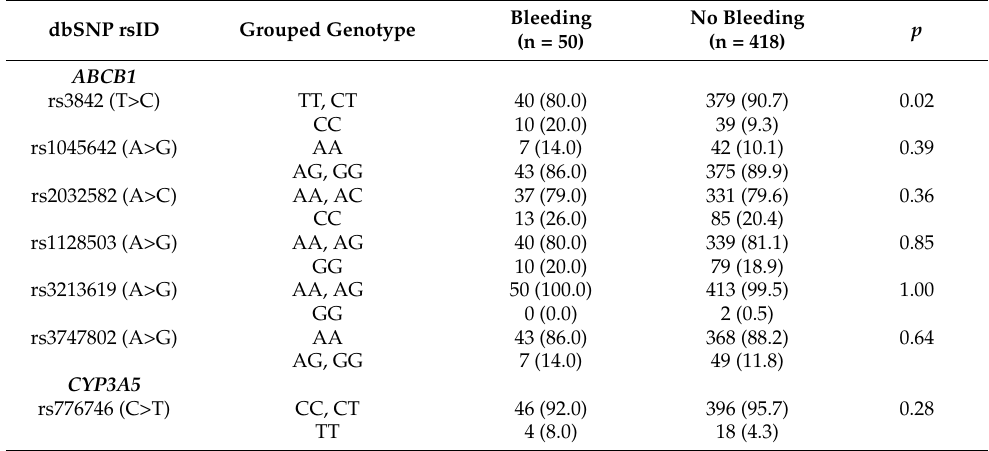
Table 2. Effects of ABCB1 and CYP3A5 grouped genotypes on bleeding complication.